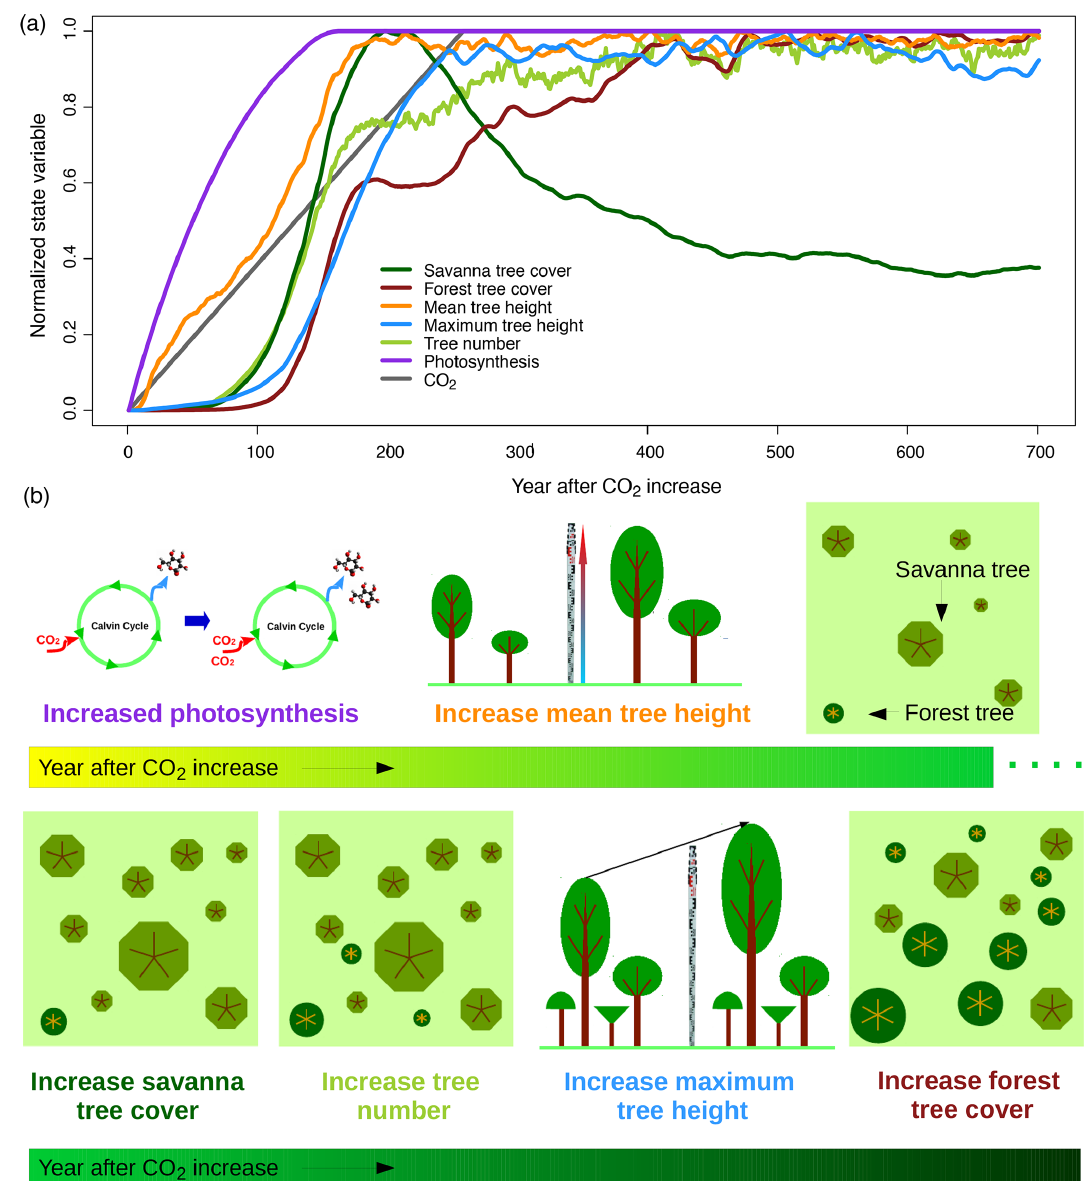
Figure 10. Vegetation responses to increasing CO 2 . Panels show (a) time series of different state variables at a savanna study site in South Africa (26 ◦ S, 28 ◦ E) and (b) a schematic illustration of processes. State variables represent averages of 200 replicate simulation runs for the site. Normalization of state variables between zero and 1 based on minimum and maximum values was applied to be able to illustrate temporal lags between variables. Figure S3 provides the time series without normalization and with units of respective